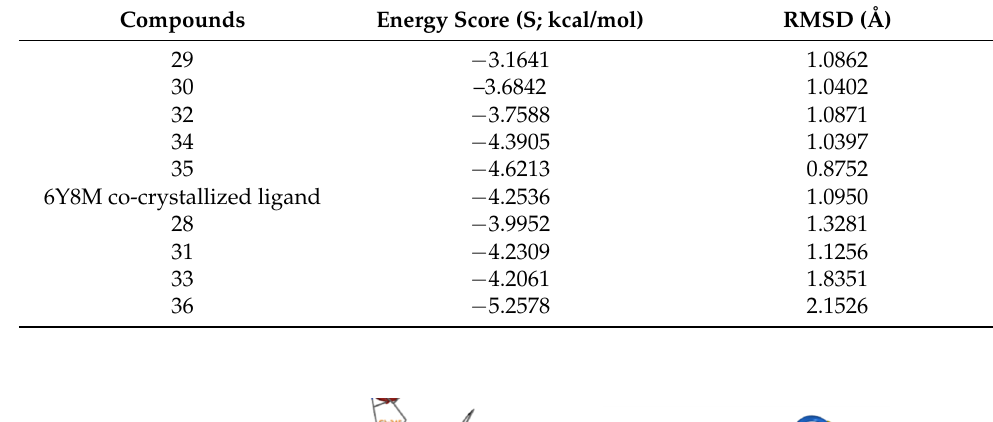
Table 5. Interaction binding energy (S; kcal/mol) and binding accuracy (RMSD; A) of isolated com- pounds from V. vinifera seeds and co-crystallized ligand within the IL-1 β active site (PDB ID: 6Y8M).